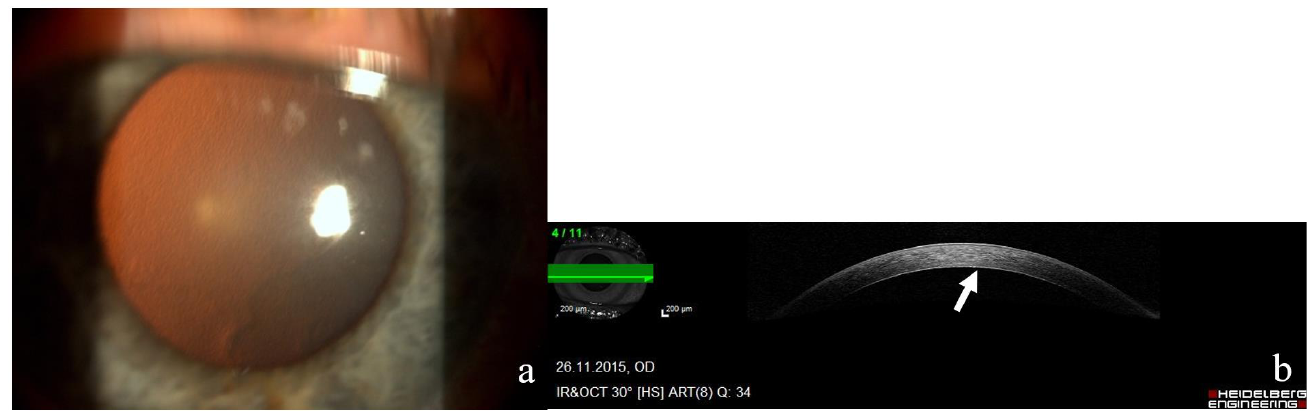
Figure 1. ( a ) Photograph of the right cornea of a 65-year-old female patient with moderate-stage Fuchs’ endothelial corneal dystrophy and characteristic endothelial guttae. ( b ) Anterior-segment optical-coherence tomograph from Heidelberg Spectralis of the same patient’s right cornea. Fine endothelial changes (arrow), corneal thickness is within normal limits — 575 micrometers.